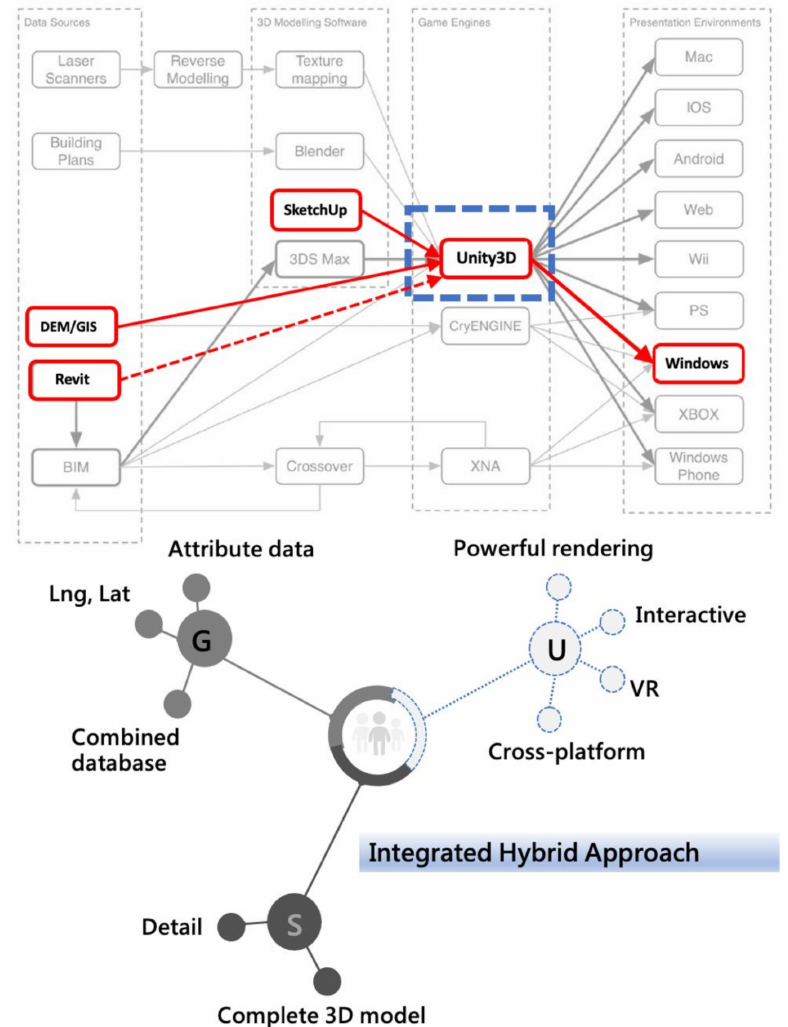
Figure 2. Integrated hybrid